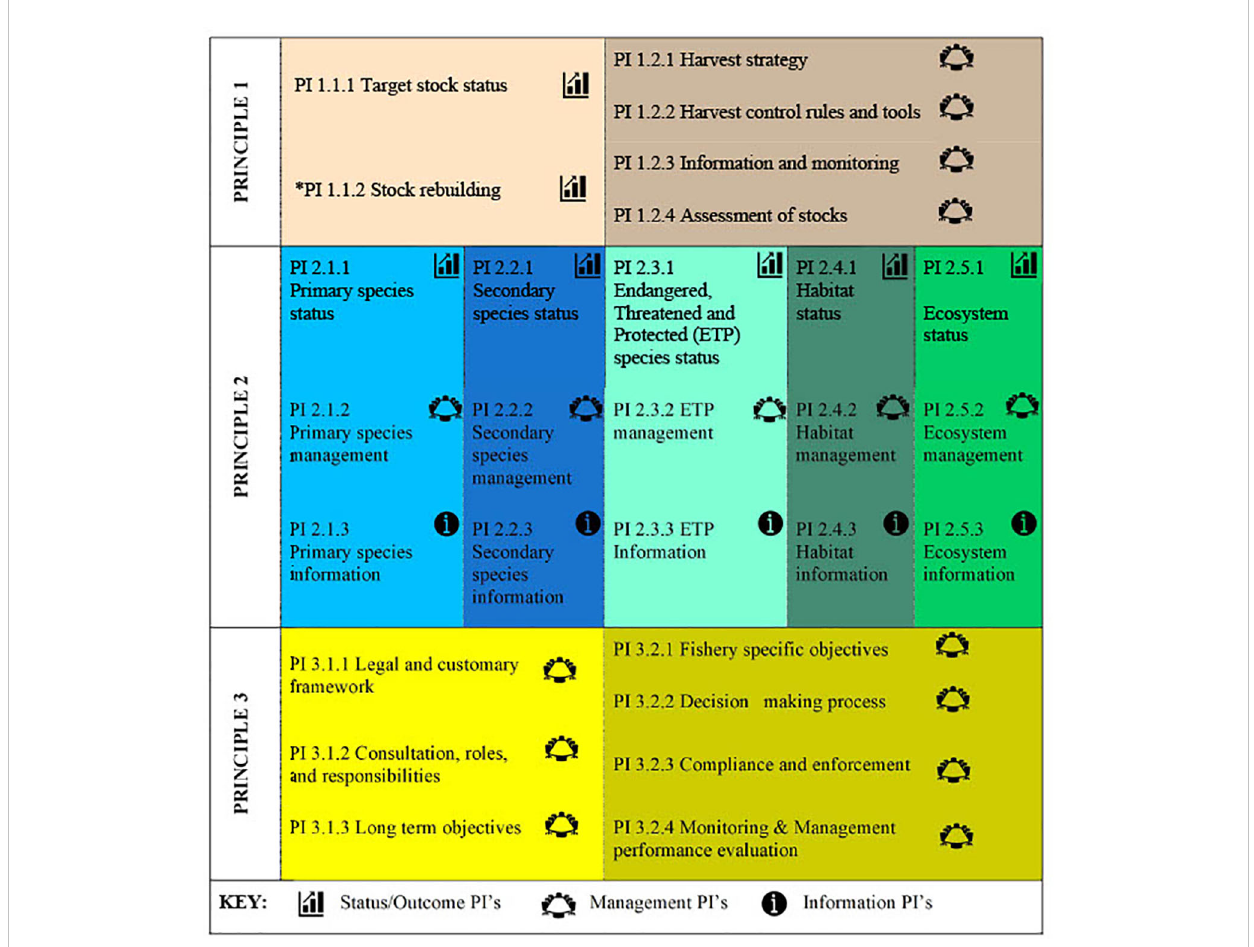
FIGURE 1 Structural outline of the MSC fi sheries standard (the default assessment tree, V2.01) showing the three overarching principles, their components and the 28 Performance Indicators (PIs). The colors of the different components correspond to those used in Figures 2A – C. *Note that PI 1.1.2 is only scored when PI 1.1.1 scores between 60 and